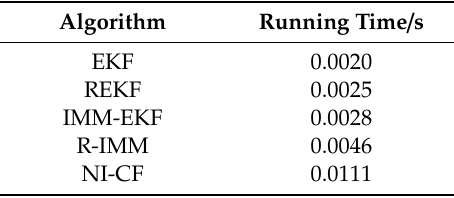
Figure 16. The CDF versus the localization error. Table 7. Running time of each algorithm.